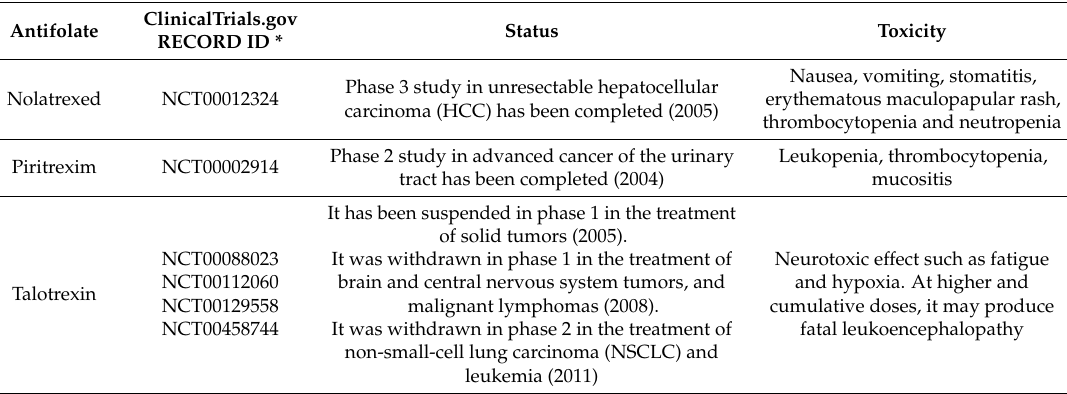
Table 2. DHFR inhibitors withdrawn from clinical